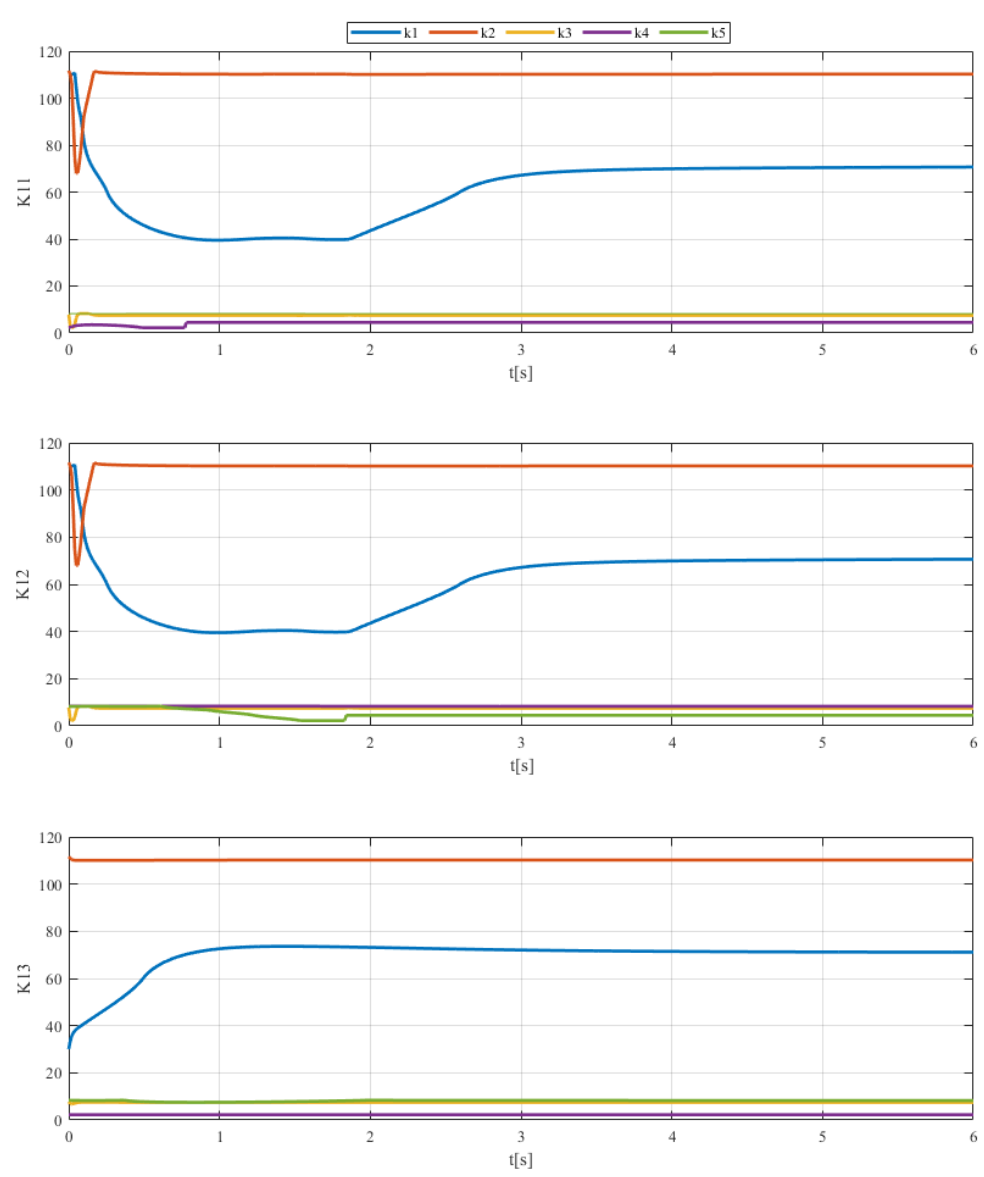
Figure 7. Controller gains of FLC for K11 (scenario 1, area 1), K12 (scenario 1, area 2), and K13 (scenario 1, area